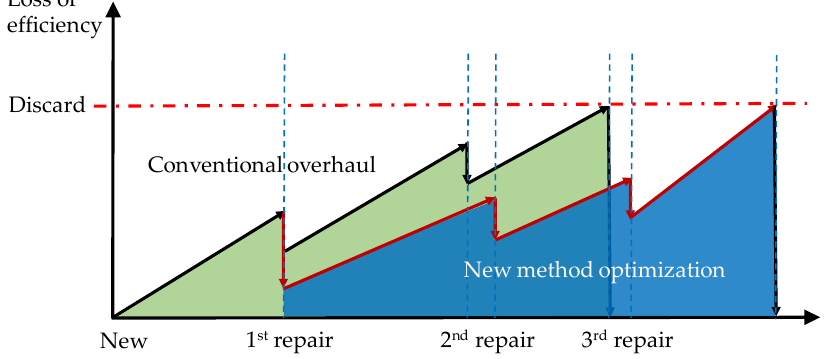
Figure 23. Comparison of the efficiency loss and refurbishment costs of conventionally overhauled and optimized blades. Reproduced from [33].